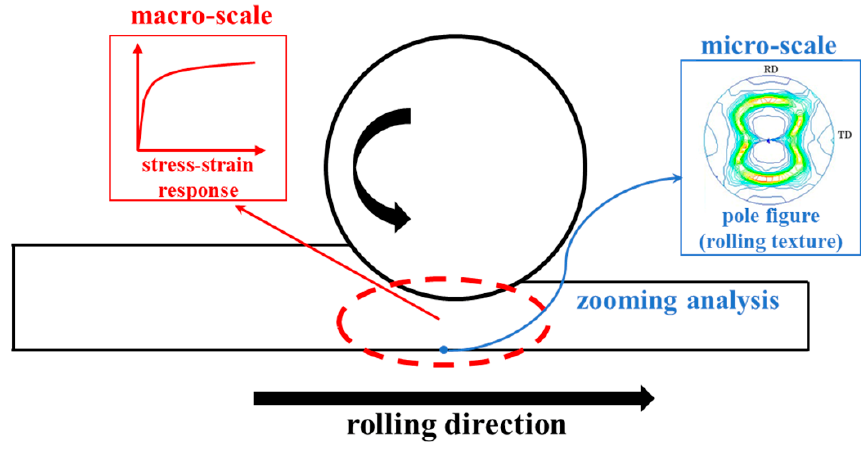
Figure 5. Schematic of the current analysis framework.